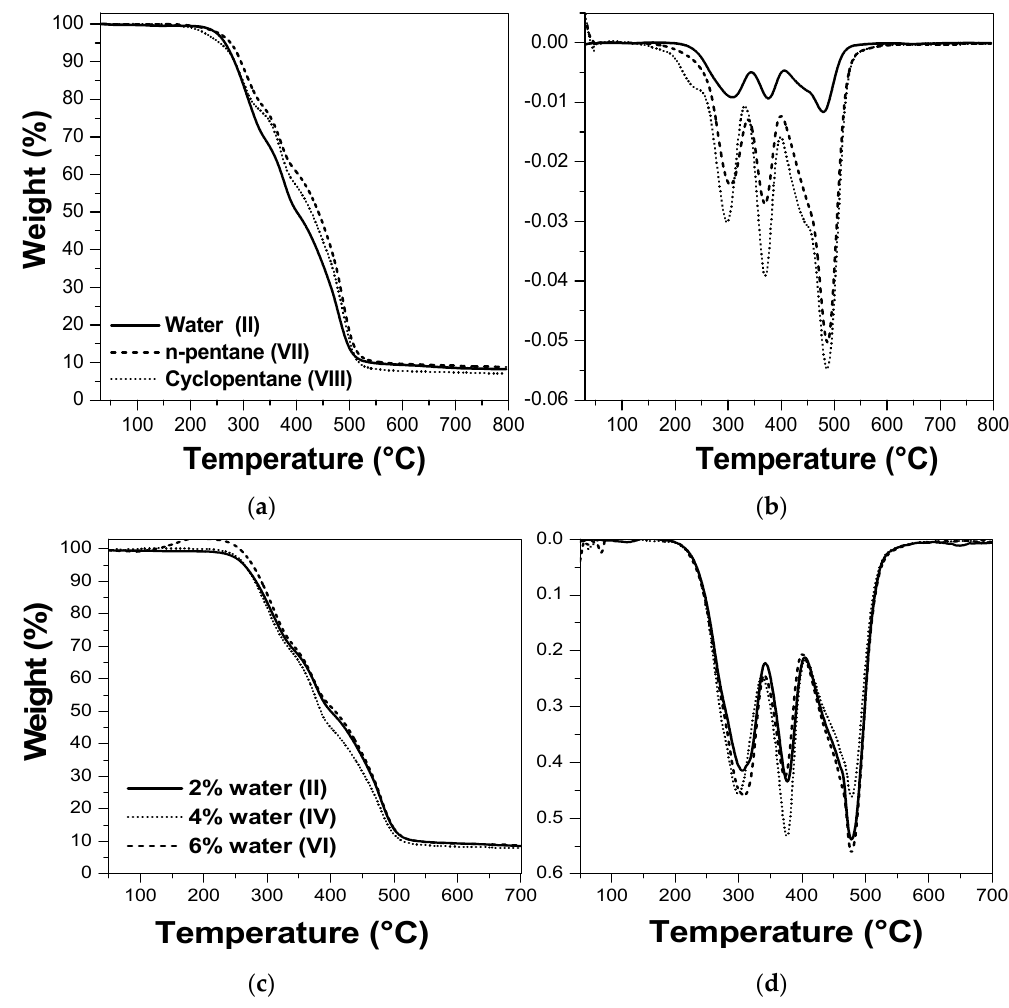
Figure 4. Thermogravimetric analysis: TGA ( a , c ) and DTG ( b , d ) curves of foams with GCo polyol with different types and amounts of blowing agents. ( a , b ) formulations II,VII, VIII; ( c , d ) formulations II, IV, VI of foams shown in Table 1. VI of foams shown in Table